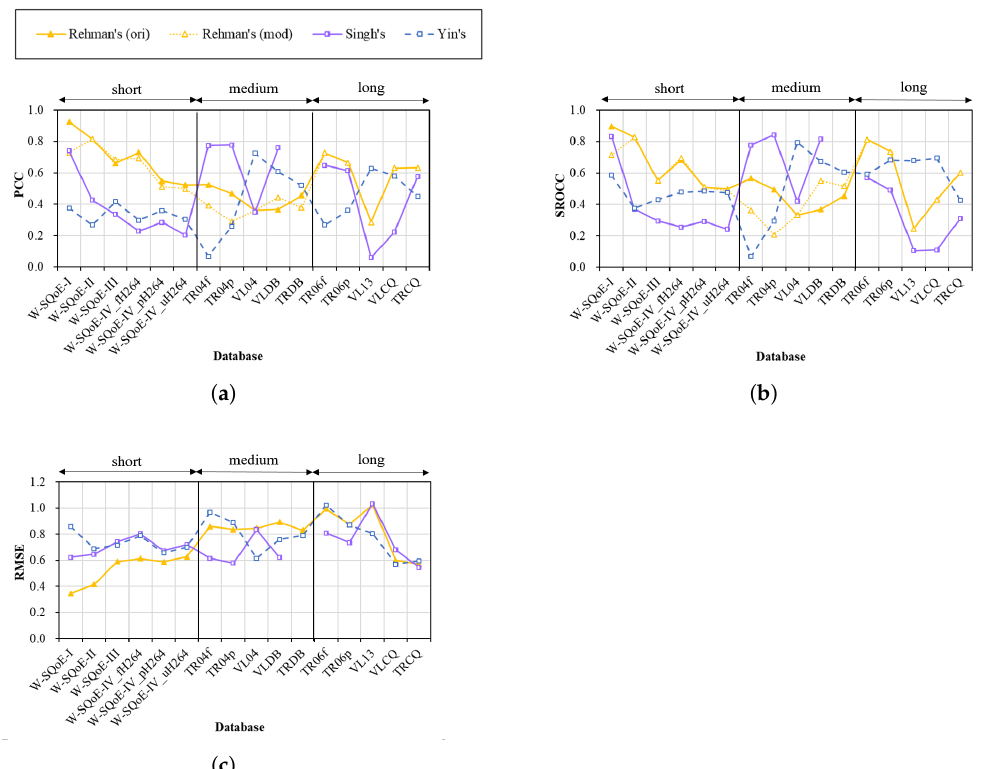
Figure 6. Performance of Rehman’s , Singh’s , and Yin’s models in the first group over the test databases. ( a ) PCC; ( b ) SROCC; ( c )